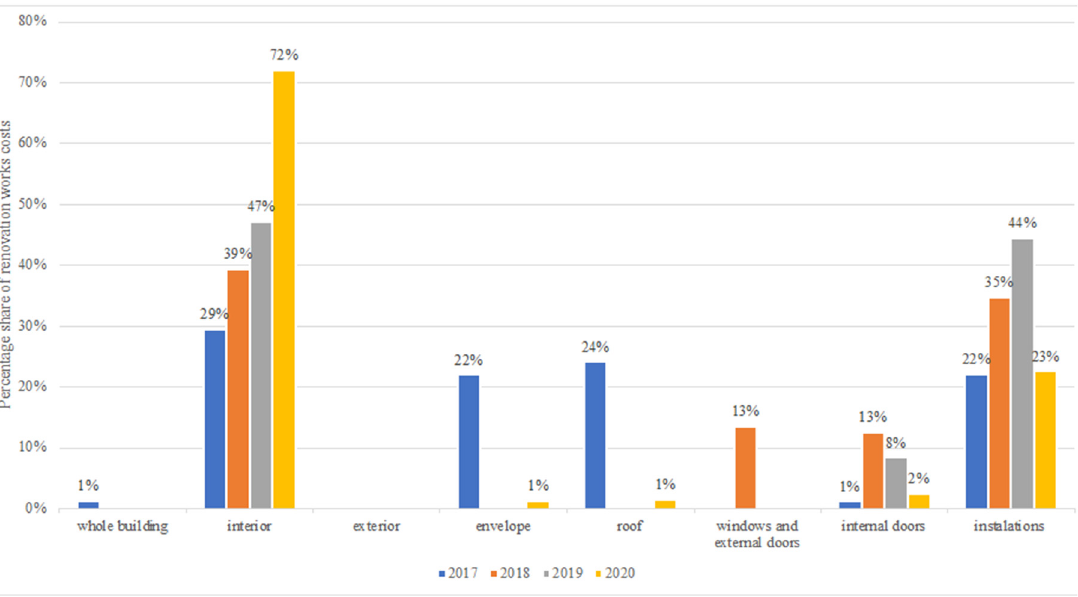
Figure 2. Renovation costs’ share (in %), divided into years of analysis.